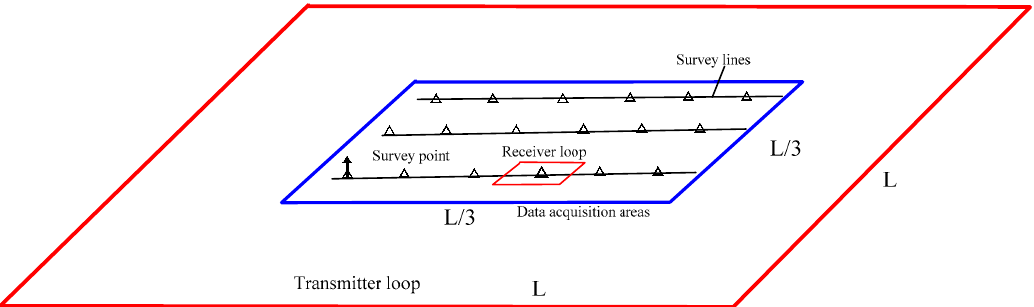
Figure 5. Large-loop TEM configuration used in the field.